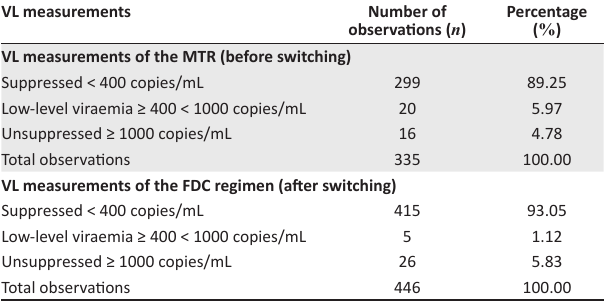
TABLE 6: Description of the viral load results before and after switching to a fixed-dose combination